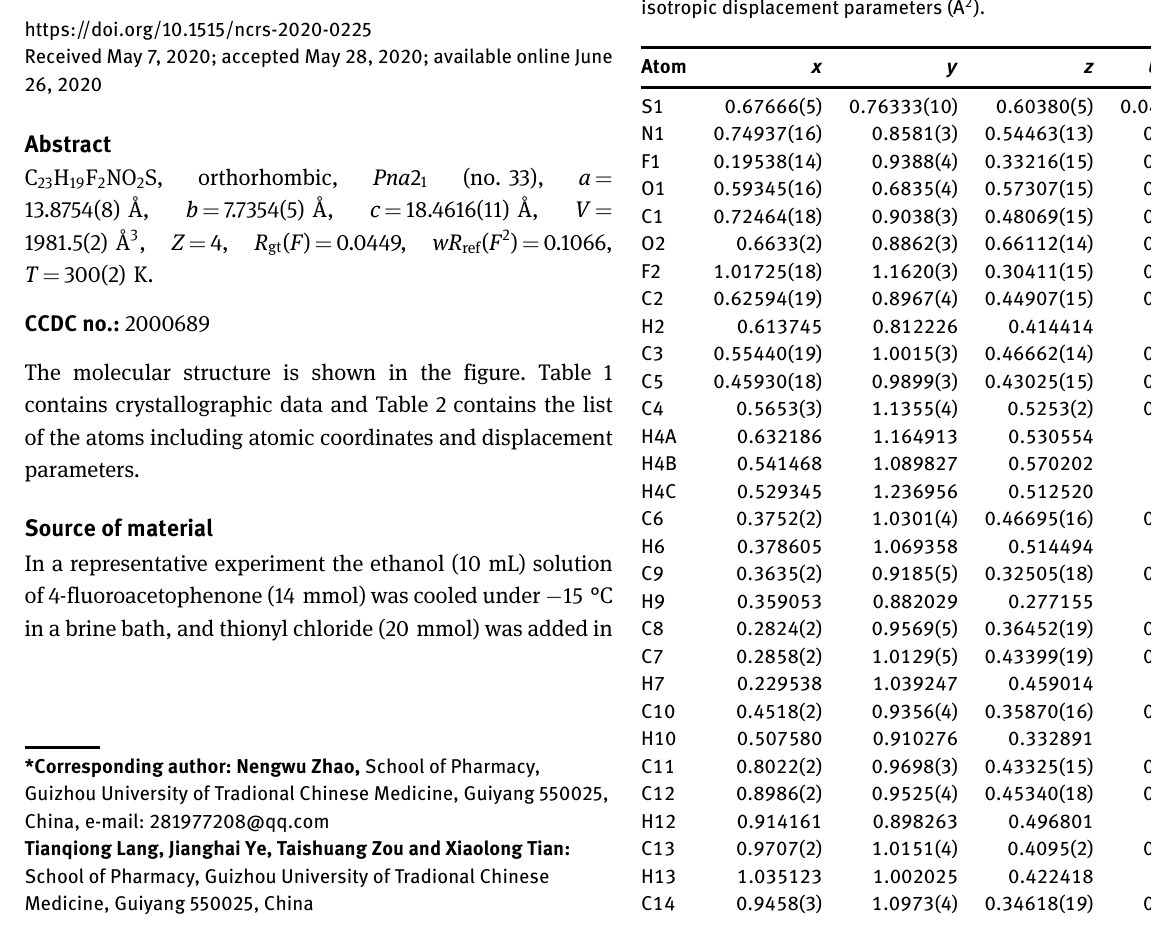
Table 2: Fractional atomic coordinates and isotropic or equivalent isotropic displacement parameters (Å 2